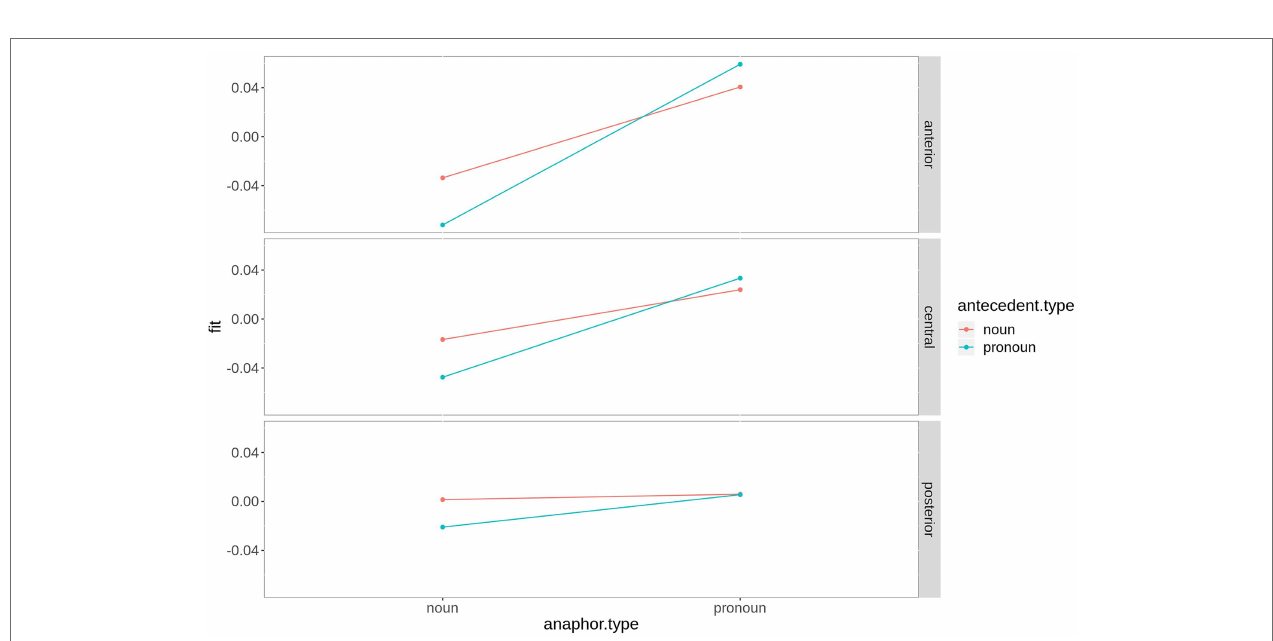
FIGURE 7 | Fitted values for the interaction saggitality*antecedent type*anaphor type in the N400 time window. For plotting purposes, the continuous variable saggitality was grouped into ROIs based on two-dimensional